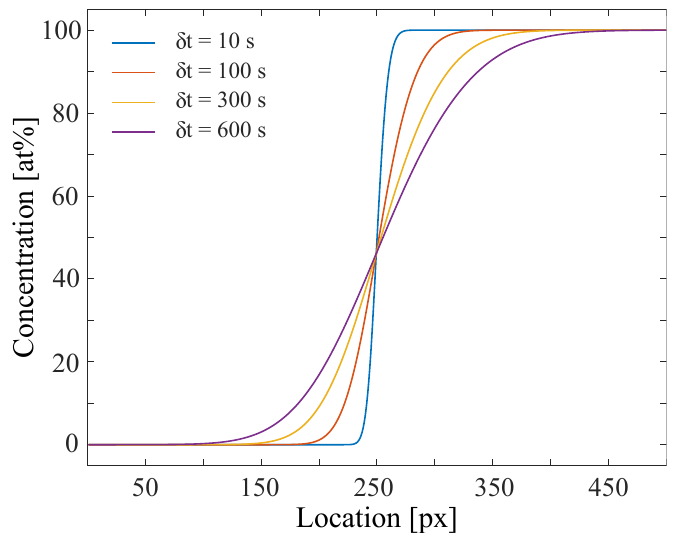
Figure 2. Interdiffusion simulation of a concentration profile starting from a step function of maxi- mum concentration difference (0 and 100 at% of specimen B in A) propagating with time. The diffu- sion coefficient D ( c ) ranges from 6 to 10 [ × 10 − 9 m 2 /s] (referred to 1st D ( c ) of Figure